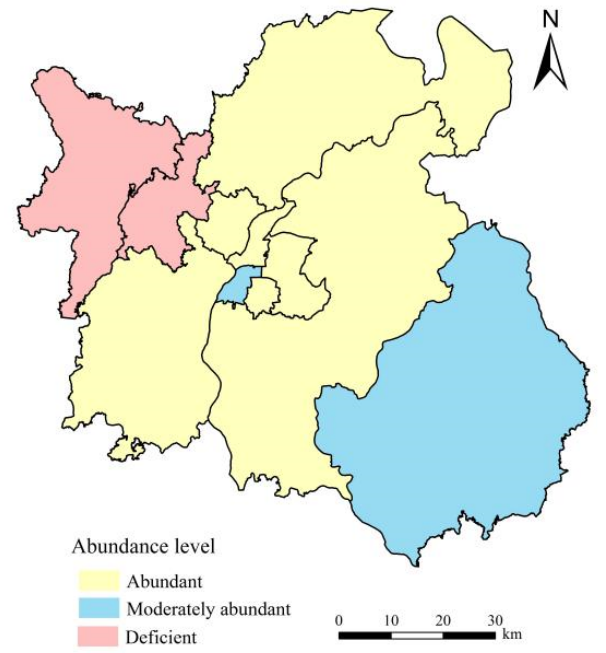
Figure 4. Spatial distribution of the abundance of available land for urban-rural construction in the study region.